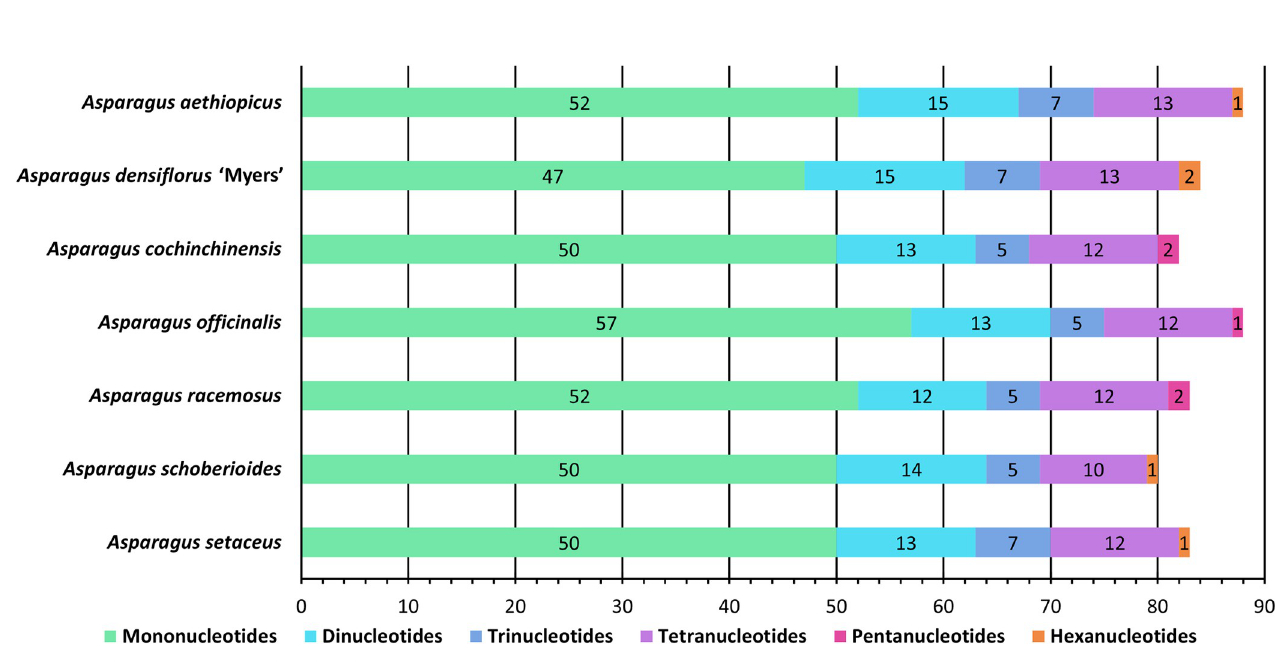
Fig 3. Simple sequence repeat class